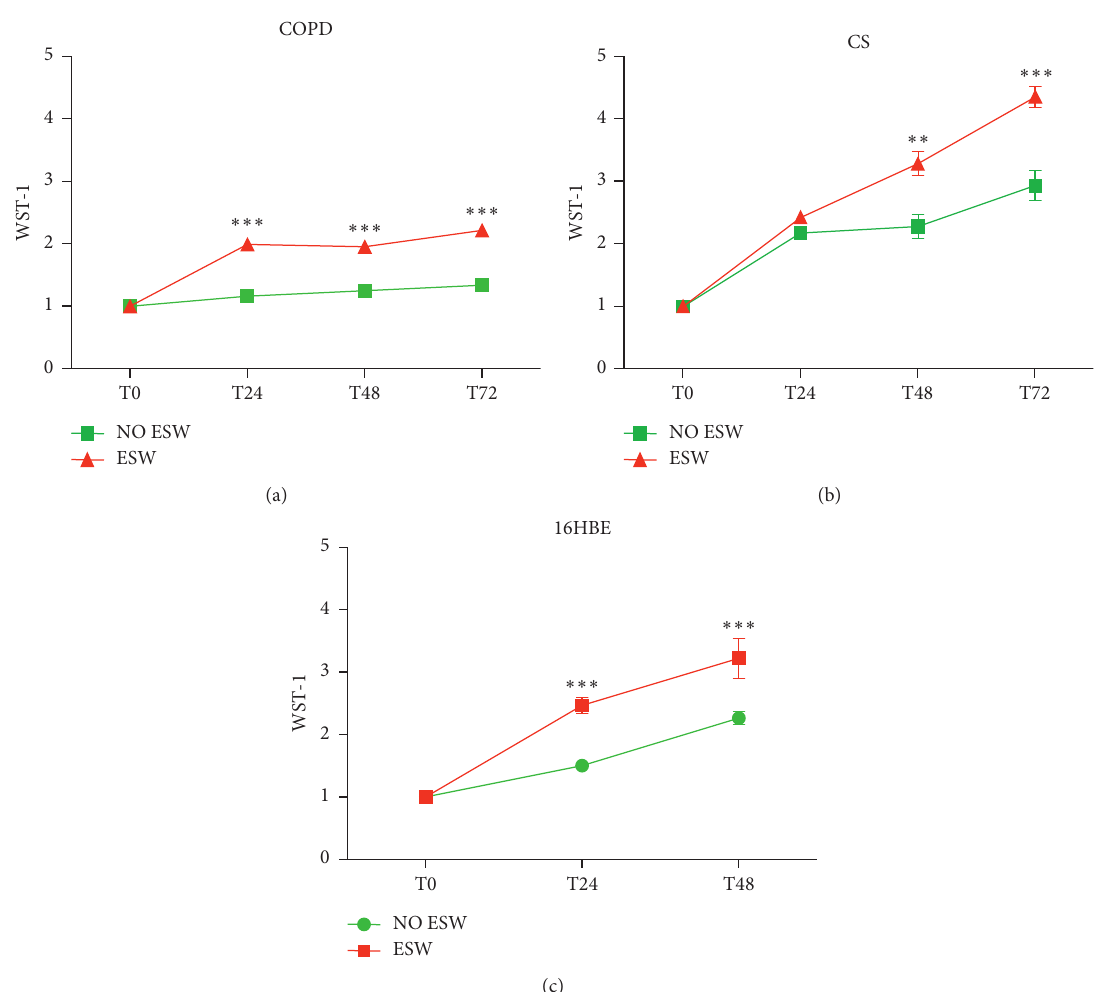
Figure 1: WST-1 test for evaluation of cell proliferation after extracorporeal shock wave (ESW) stimulation of primary bronchial fibroblasts of COPD patients ( n � 3) (a), primary bronchial fibroblasts of control smokers ( n � 3) (b), and bronchial epithelial cells (16HBE) (c). Increased cell proliferation was observed in all cellular types studied after challenge with ESW. T -test: ∗∗ p < 0.01 and ∗∗∗ p <